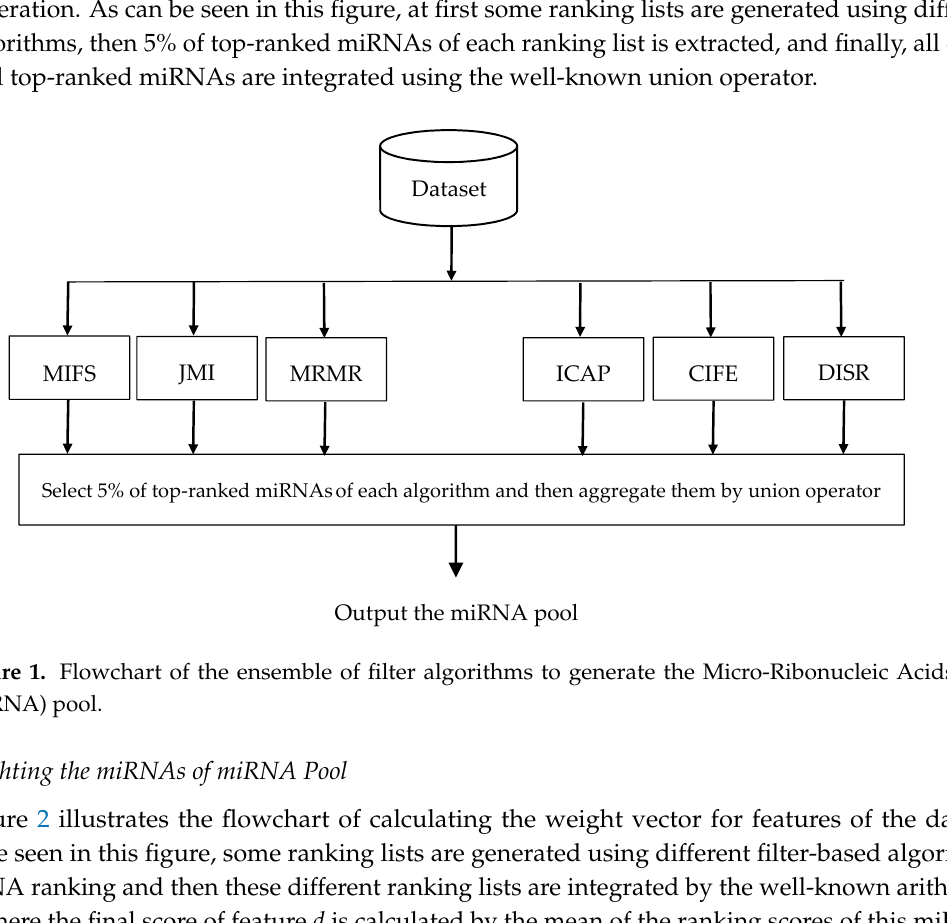
Figure 2. Flowchart of the ensemble of filter algorithms to calculate the weight vector.